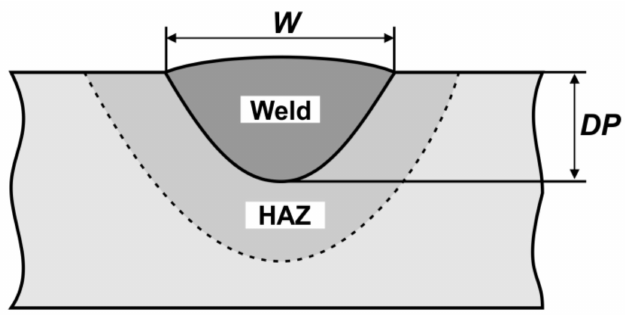
Figure 1. Schematic diagram of the bead-on-plate weld (DP—depth of penetration;